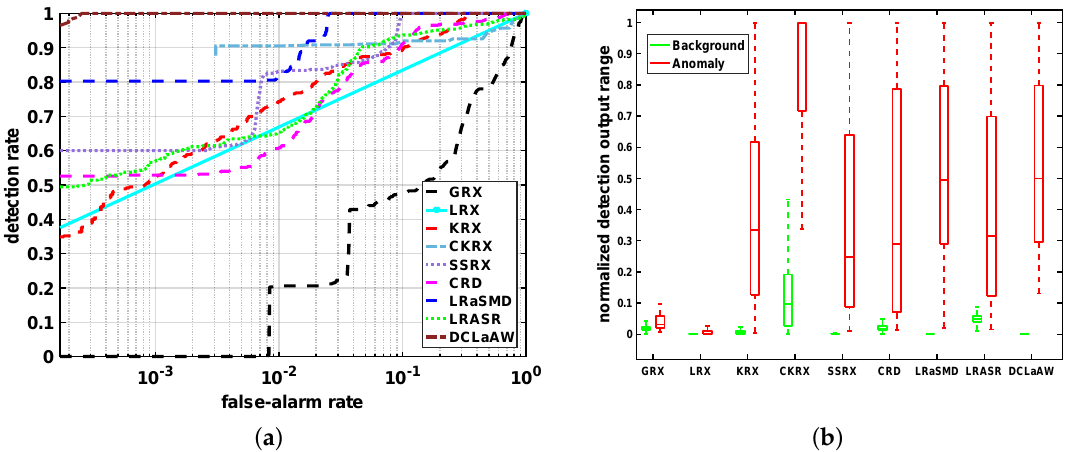
Figure 14. Quantitative comparisons of all compared algorithms for the synthetic dataset. ( a ) ROC curves; ( b ) Background-anomaly separation